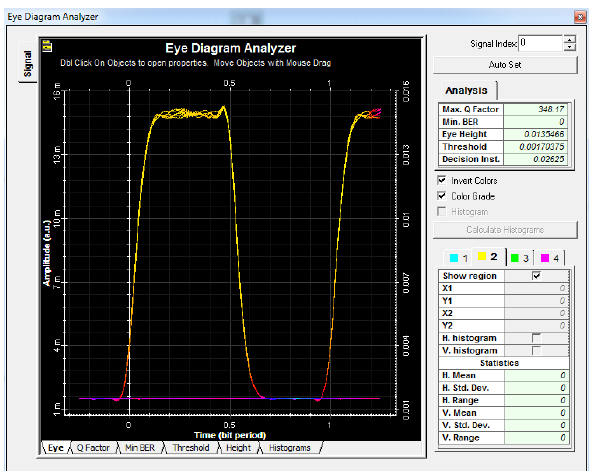
Figure 5: Results of the eye diagram analyzer with the directly modulated laser source along a cable length of 20 km.